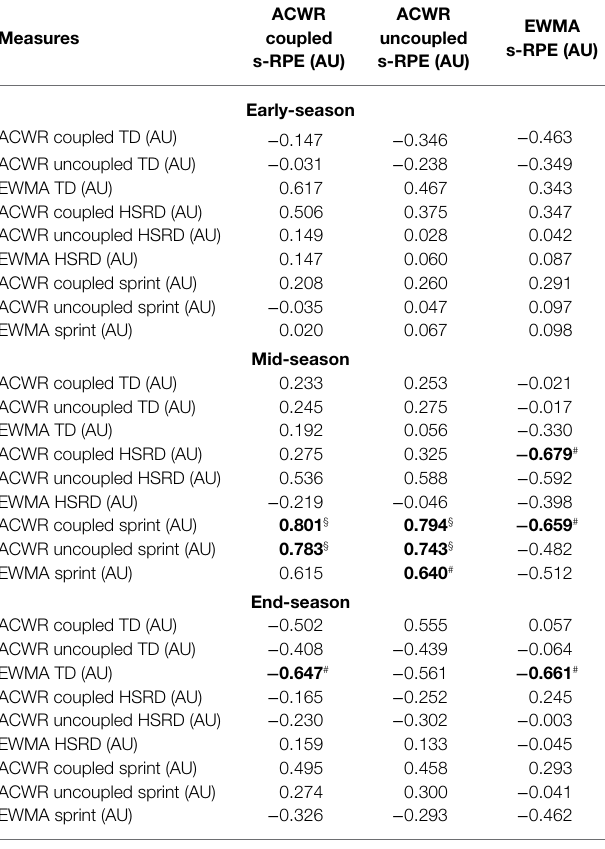
TABLE 3 | Correlation analysis between external and internal load measures during three periods of the in-season for the starter’s status.